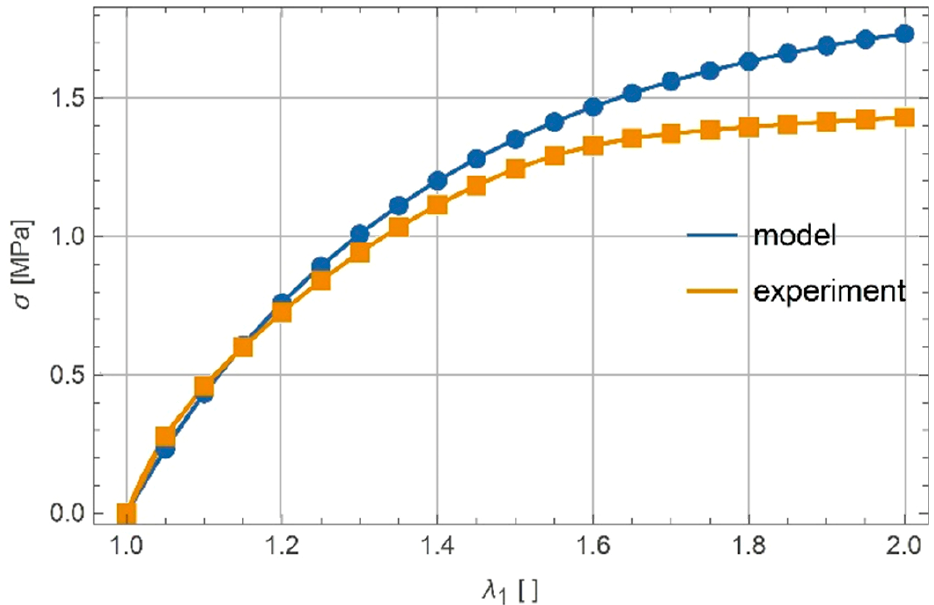
Figure 9. Response in tension with 𝛼 and 𝛽 calibrated for shear.